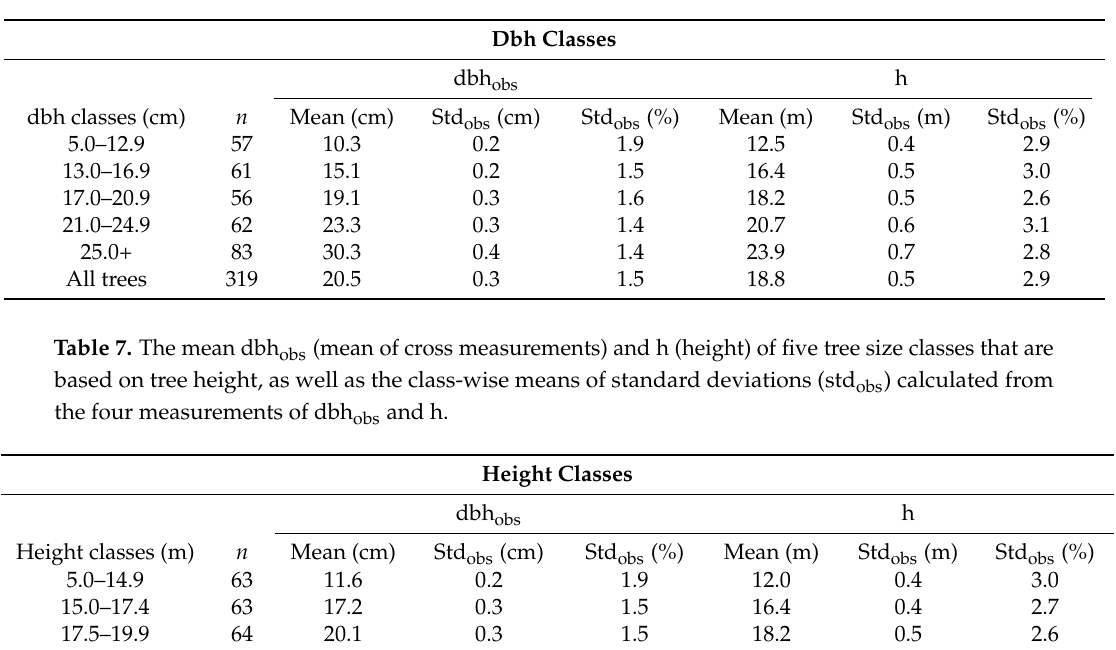
Figure 4. Boxplot describing the standard deviations (std) of sample tree dbh (diameter-at-breast-height) measurements with two different methods. On left, the standard deviation is a result of dbh values acquired using cross-measurements (i.e., dbh obs ), whereas on right, only one dbh measurement per mensurationist was used. Table 6. The mean dbh obs (mean of cross measurements) and h (height) of the five tree size classes that are based on the dbh, as well as the class-wise means of standard deviations (std obs ) calculated from the four observations of dbh obs and h.